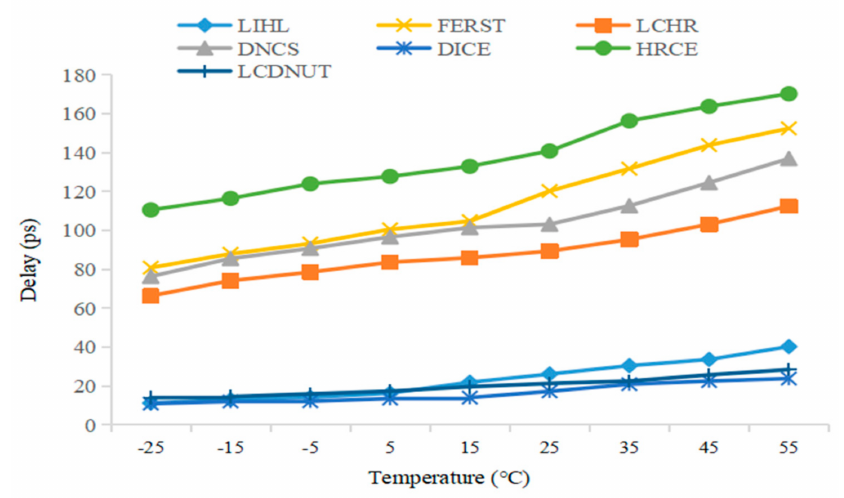
Figure 18. Delay comparison of various latch designs under different